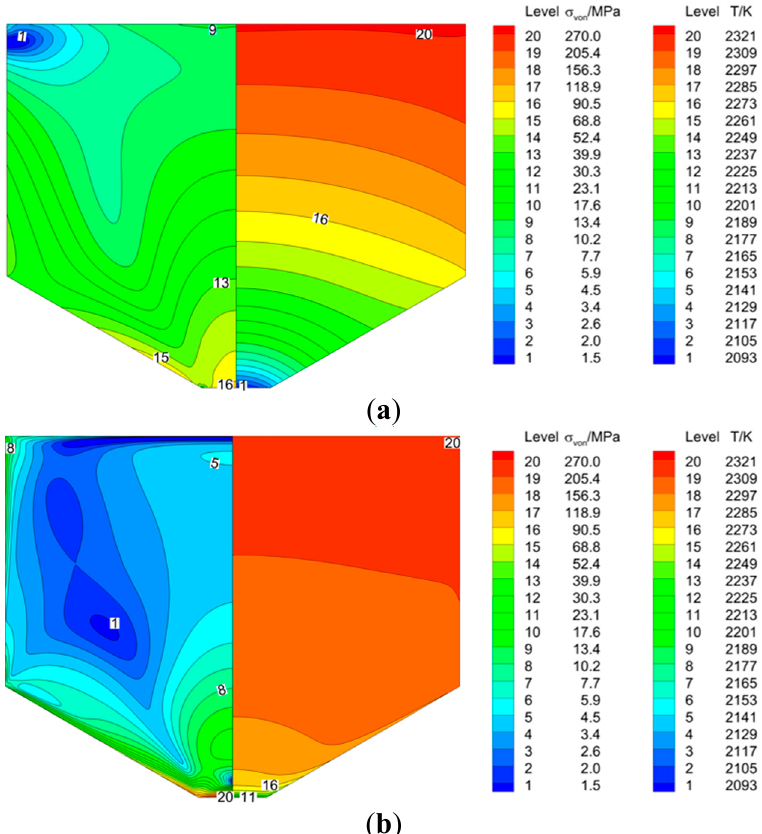
Figure 2. Temperature ( right ) and thermal stress ( left ) distributions in the crystal: ( a ) without; and ( b ) with internal radiation at the end of the solidification process.